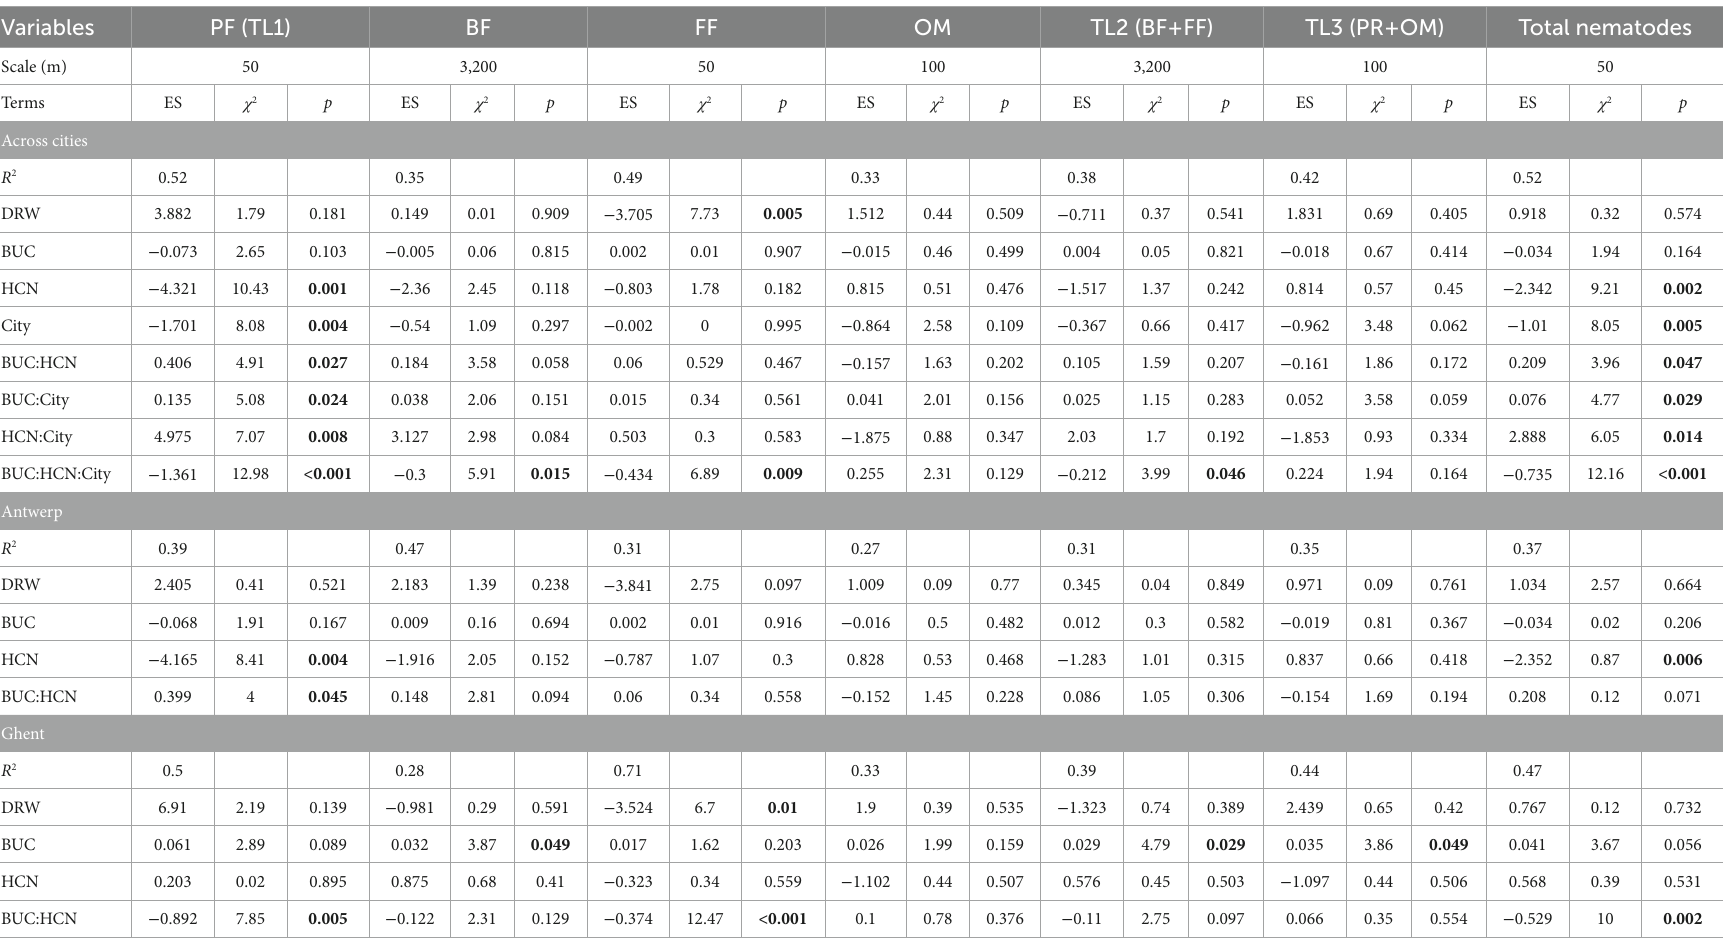
TABLE 1 Outputs of negative-binomial generalized linear models that test the effects of HCN frequency (HCN) and urbanization level (BUC) and their interaction on root-associated nematode abundance across and within the cities (City) of Antwerp and Ghent.